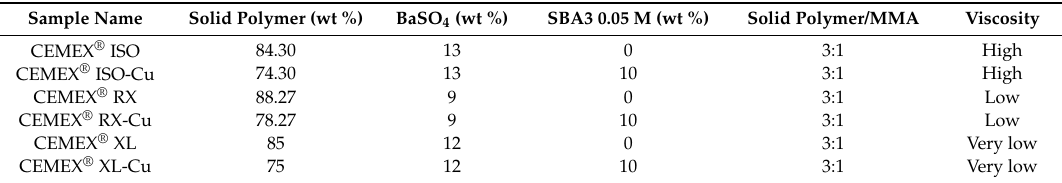
Table 1. Test materials and related